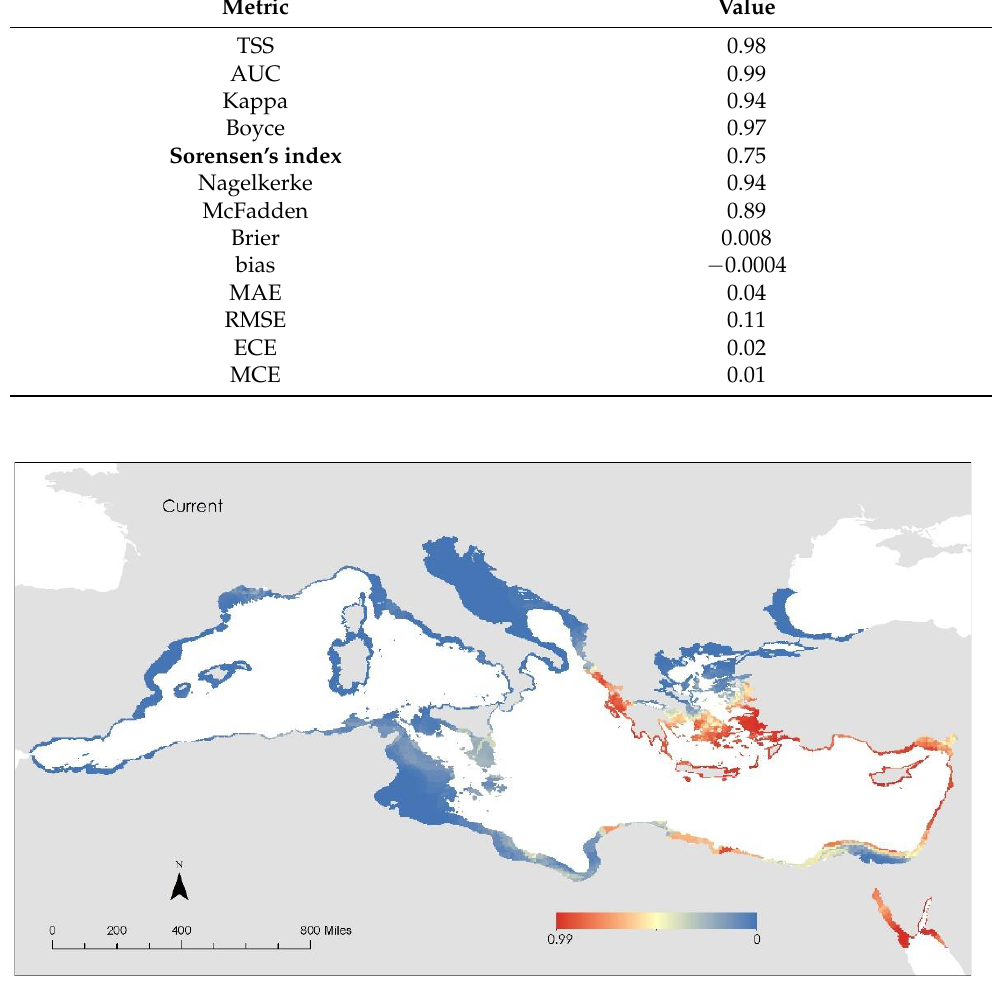
Figure 1. Lionfish potential distribution under current conditions (2000 – 2014).